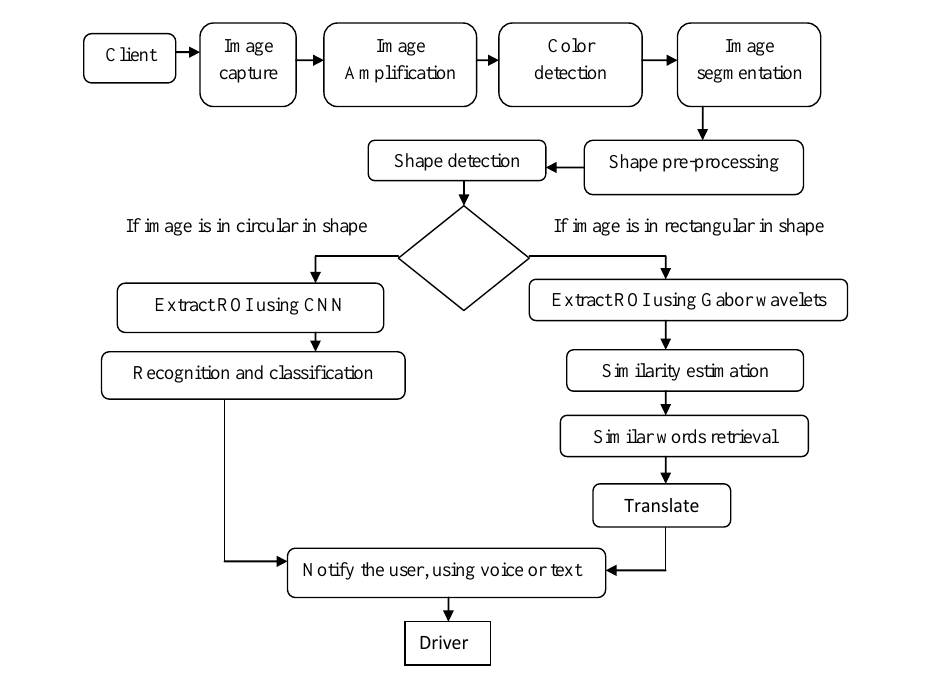
Fig. 3. Shows the flowchart of an entire system